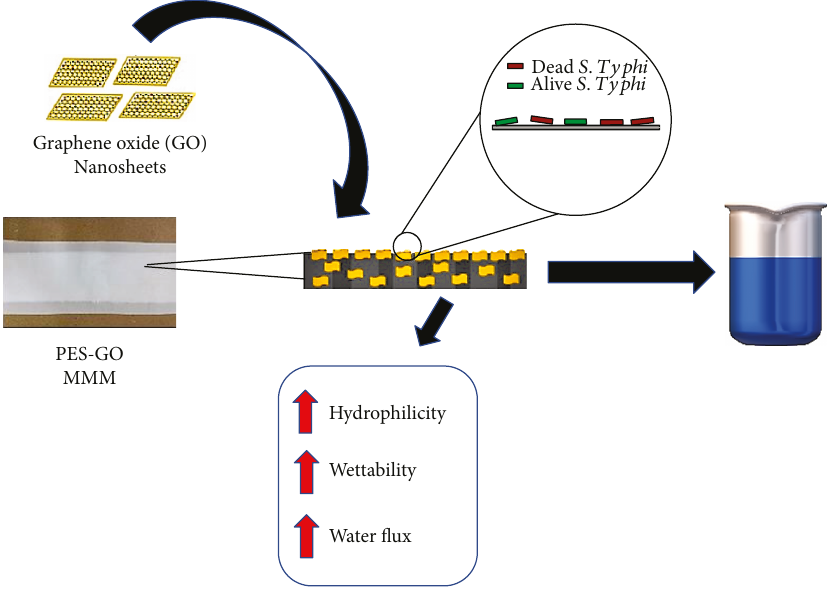
Figure 1: Graphical